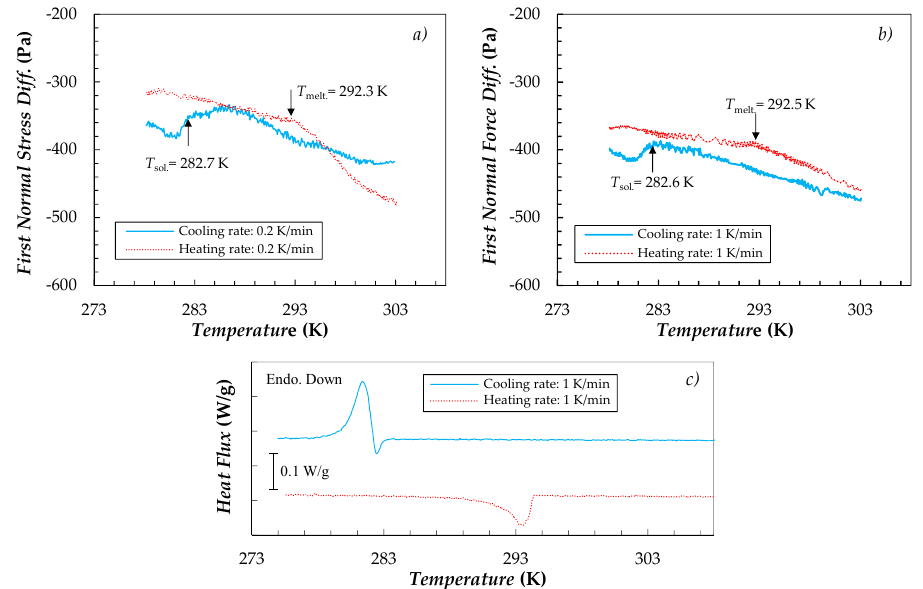
Figure 5. (a,b) First normal stress difference– temperature curves obtained for RT21HC(10 Figure 5. ( a , b ) First normal stress di ff erence– temperature curves obtained for RT21HC(10 wt.%) / Water wt.%)/Water emulsion at scanning rates of ( a ) 0.2 and ( b ) 1 K/min. ( c ) Thermogram obtained by emulsion at scanning rates of ( a ) 0.2 and ( b ) 1 K / min. ( c ) Thermogram obtained by di ff erential scanning differential scanning calorimetry in [32]. calorimetry in [32].